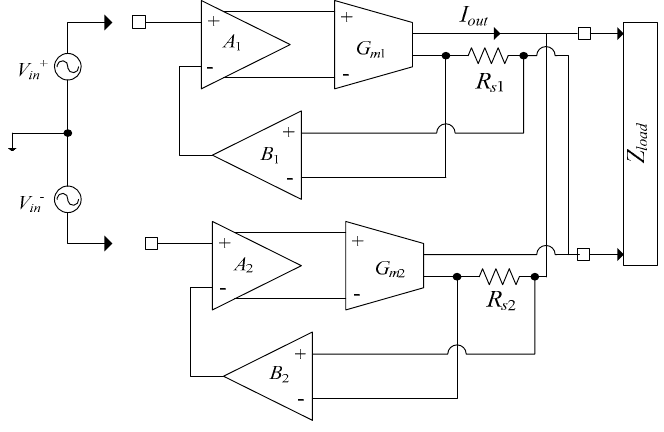
Figure 9. High power current driver [17].